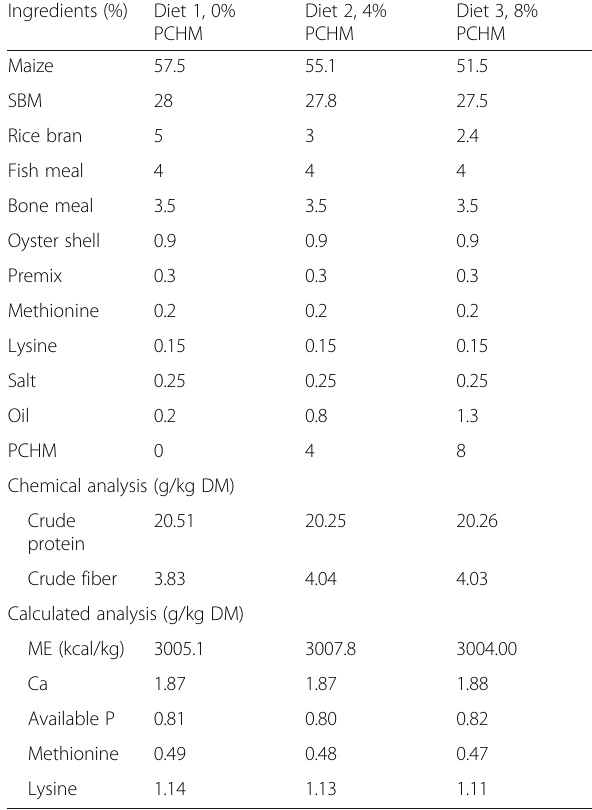
Table 1 Chemical composition of processed cocoa pod husk meal